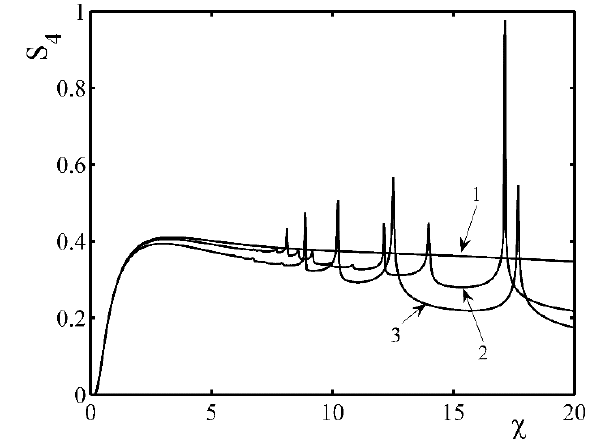
Figure 8: Scintillation index versus anisotropy coefficient for different parameter at .